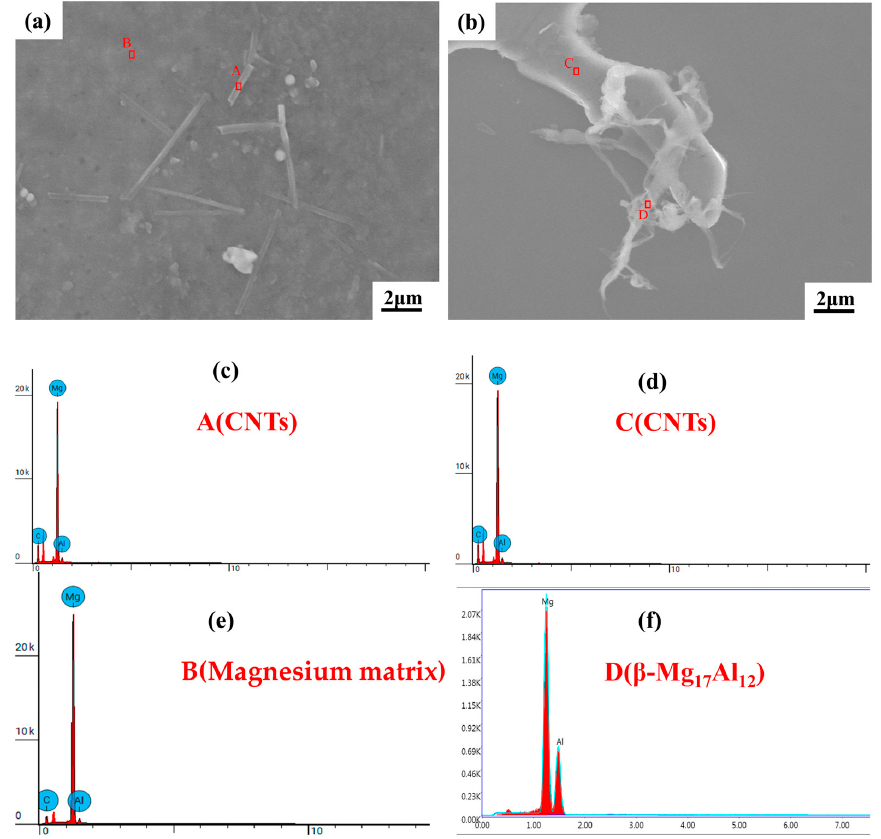
Figure 6. SEM images and EDS analysis of Ni-CNTs/AZ91 magnesium matrix composites: ( a ) uni- formly distributed Ni-CNTs in the Mg alloy matrix ( b ) wound on the β -Mg17Al12 phase ( c – f ) EDS analysis: CNTs, Magnesium matrix, CNTs, β -Mg 17 Al 12